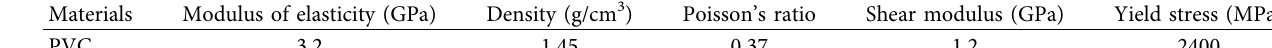
Table 5: Polyenergy tube parameters.